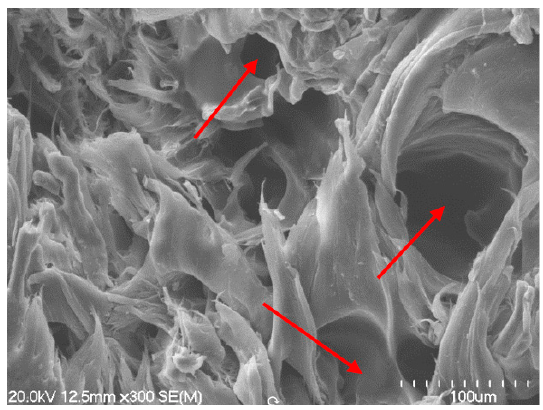
Figure 17. The 10 wt % hemp dog bone fracture surface, demonstrating excessive porosity.